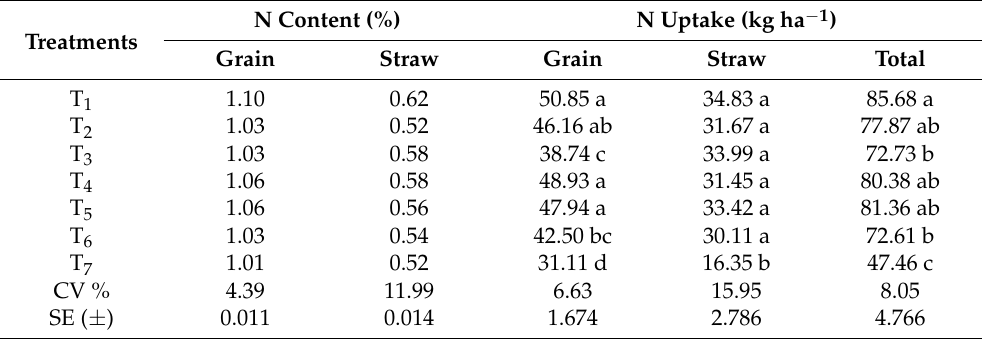
Table 3. Effect of methods of deep placement of urea fertilizer on N content and uptake of BRRI